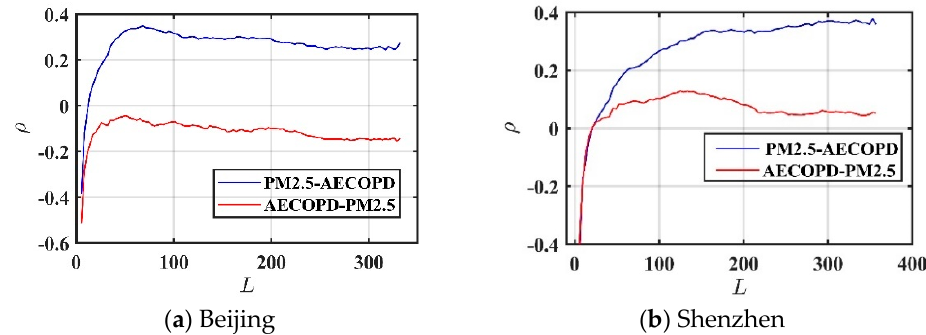
Figure 4. Convergent cross maps demonstrating the causality between PM 2.5 concentration and AECOPD in ( a ) Beijing and ( b ) Shenzhen in 2013. Table 4. Numerical result of causality ( 𝜌 value) between PM 2.5 and AECOPD in Beijing urban areas and Shenzhen City. (Value with * is significant at the 0.05 level)